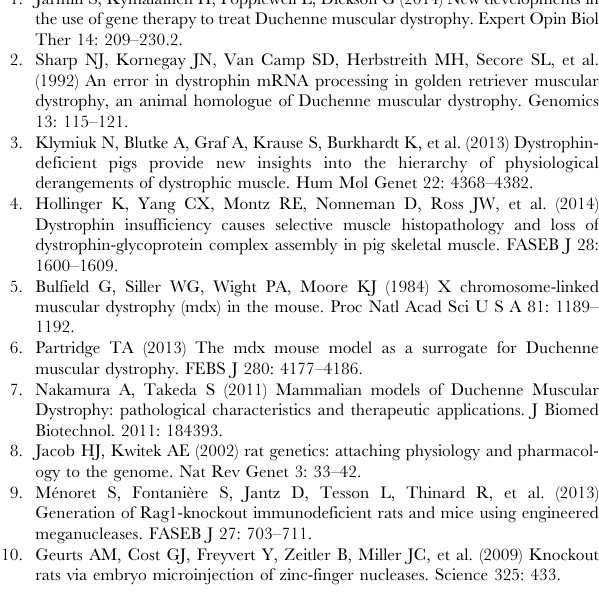
Figure S2 Growth of Dmd mdx rats. Newborns at day 2 ( A ). Figure S3 The absence of dystrophin in skeletal muscle fibers is associated with a strong reduction in alpha- sarcoglycan expression in Dmd mdx rats. Biceps femoris muscle samples were assessed for the expression of proteins of